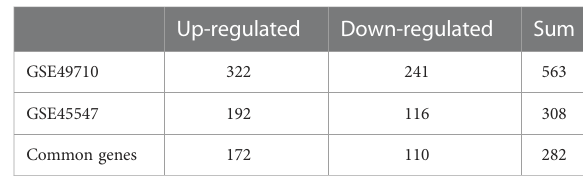
TABLE 2 DEGs screened from two